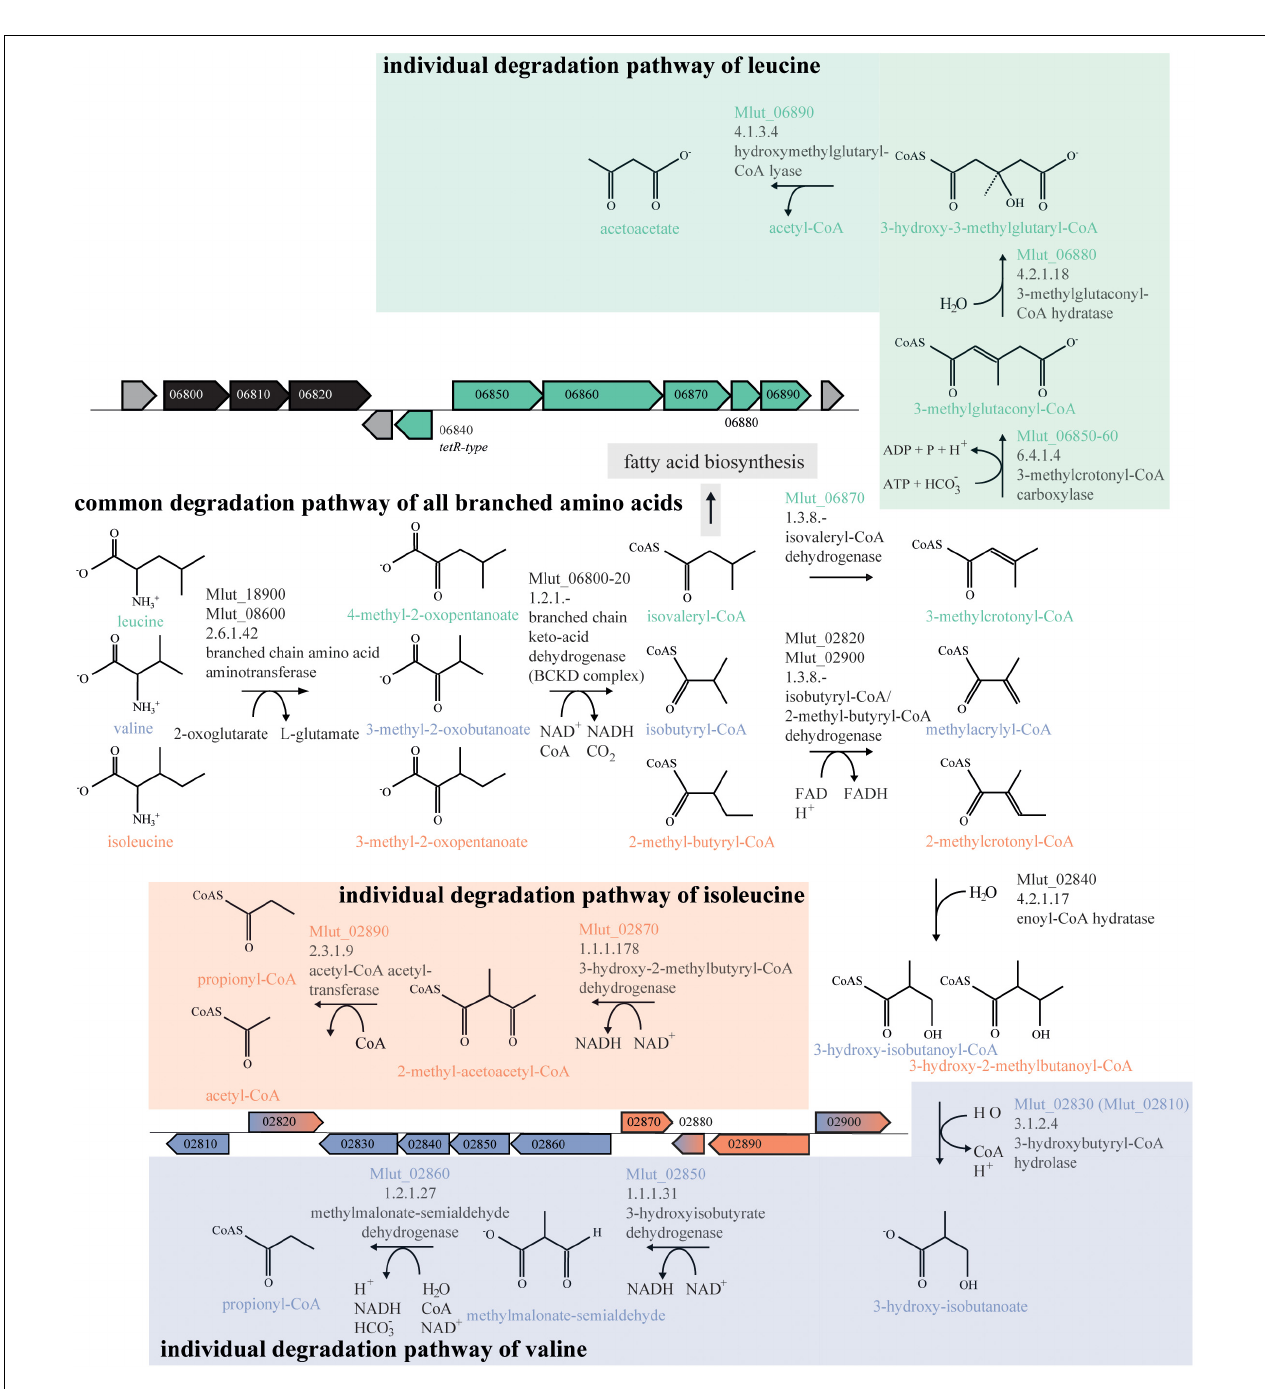
FIGURE 4 | Branched-chain amino acid (BCAA) degradation pathways in M. luteus. Metabolites genes and gene clusters written or dyed in green are part of the leucine degradation pathway, those in blue and red are part of the valine and isoleucine degradation pathways, respectively. Genes and Gene cluster dyed in black are part of the common degradation pathway. Gene cluster parts dyed in blue and red are designated to the valine and isoleucine degradation pathway. Assignment of genes to specific reactions was done using the Biocyc database and homology searches with blastp as well as on experiments from this